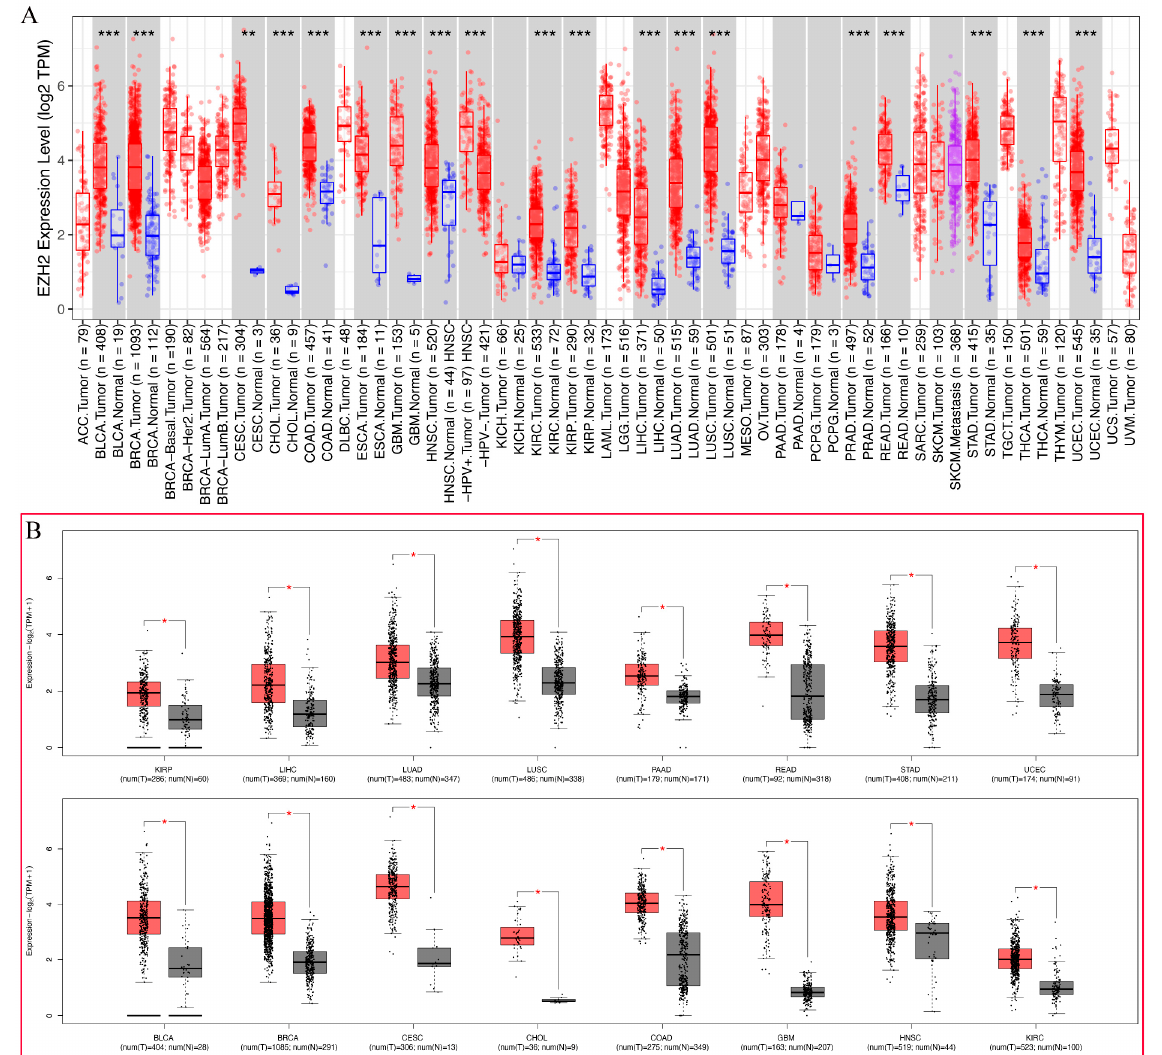
Figure 2. The differential expression of EZH2 in different tumor types. ( A ) The expression status of the EZH2 gene in different cancer types was analyzed through TIMER2 (data from TCGA). ** p < 0.01; *** p < 0.001. ( B ) The expression status of the EZH2 gene in different cancer types was analyzed through GEPIA2 (data from TCGA and GTEx). * p < 0.05.